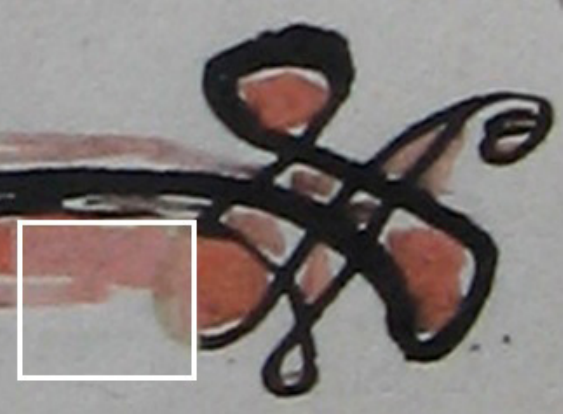
Figure 8. A fragment of an Arabic manuscript page after laser processing (the white square shows the area processed by the laser).